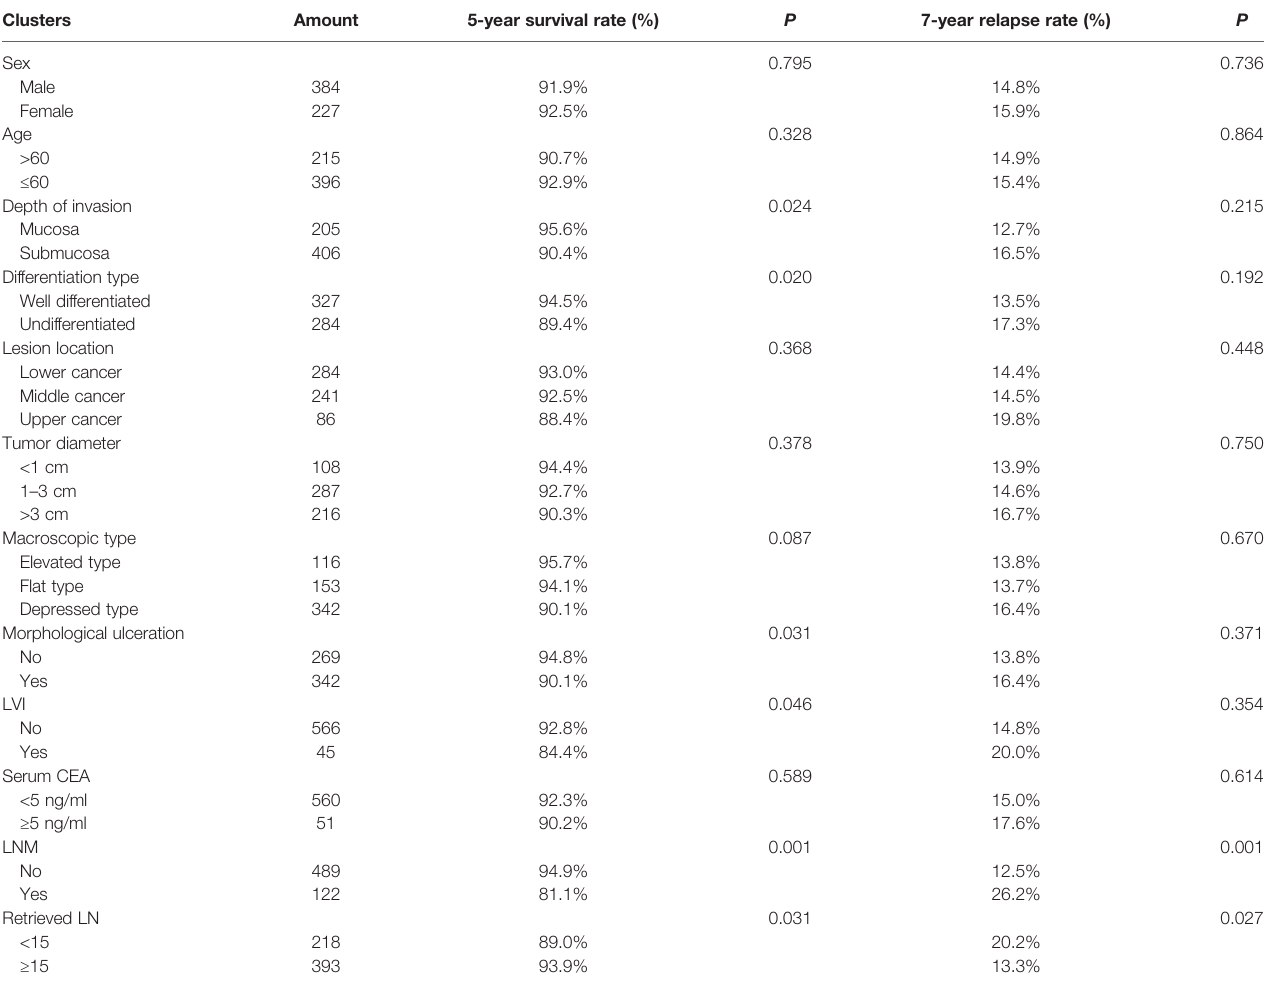
TABLE 5 | The relationship between clinicopathological characteristics and 5-year survival rate and 7-year relapse rate in EGC.